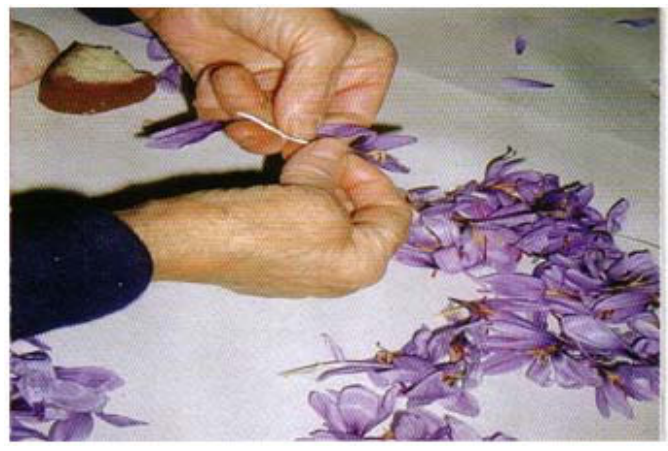
Figure 8. Separation of stigma and